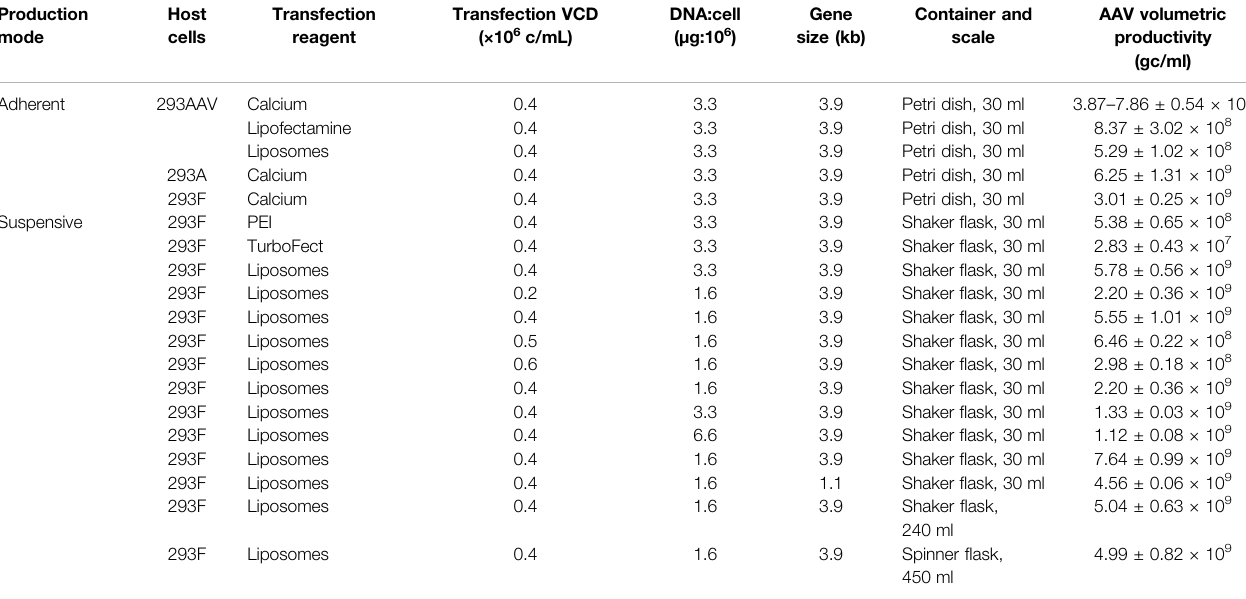
TABLE 1 | Summary of tested AAV production parameters. Production mode